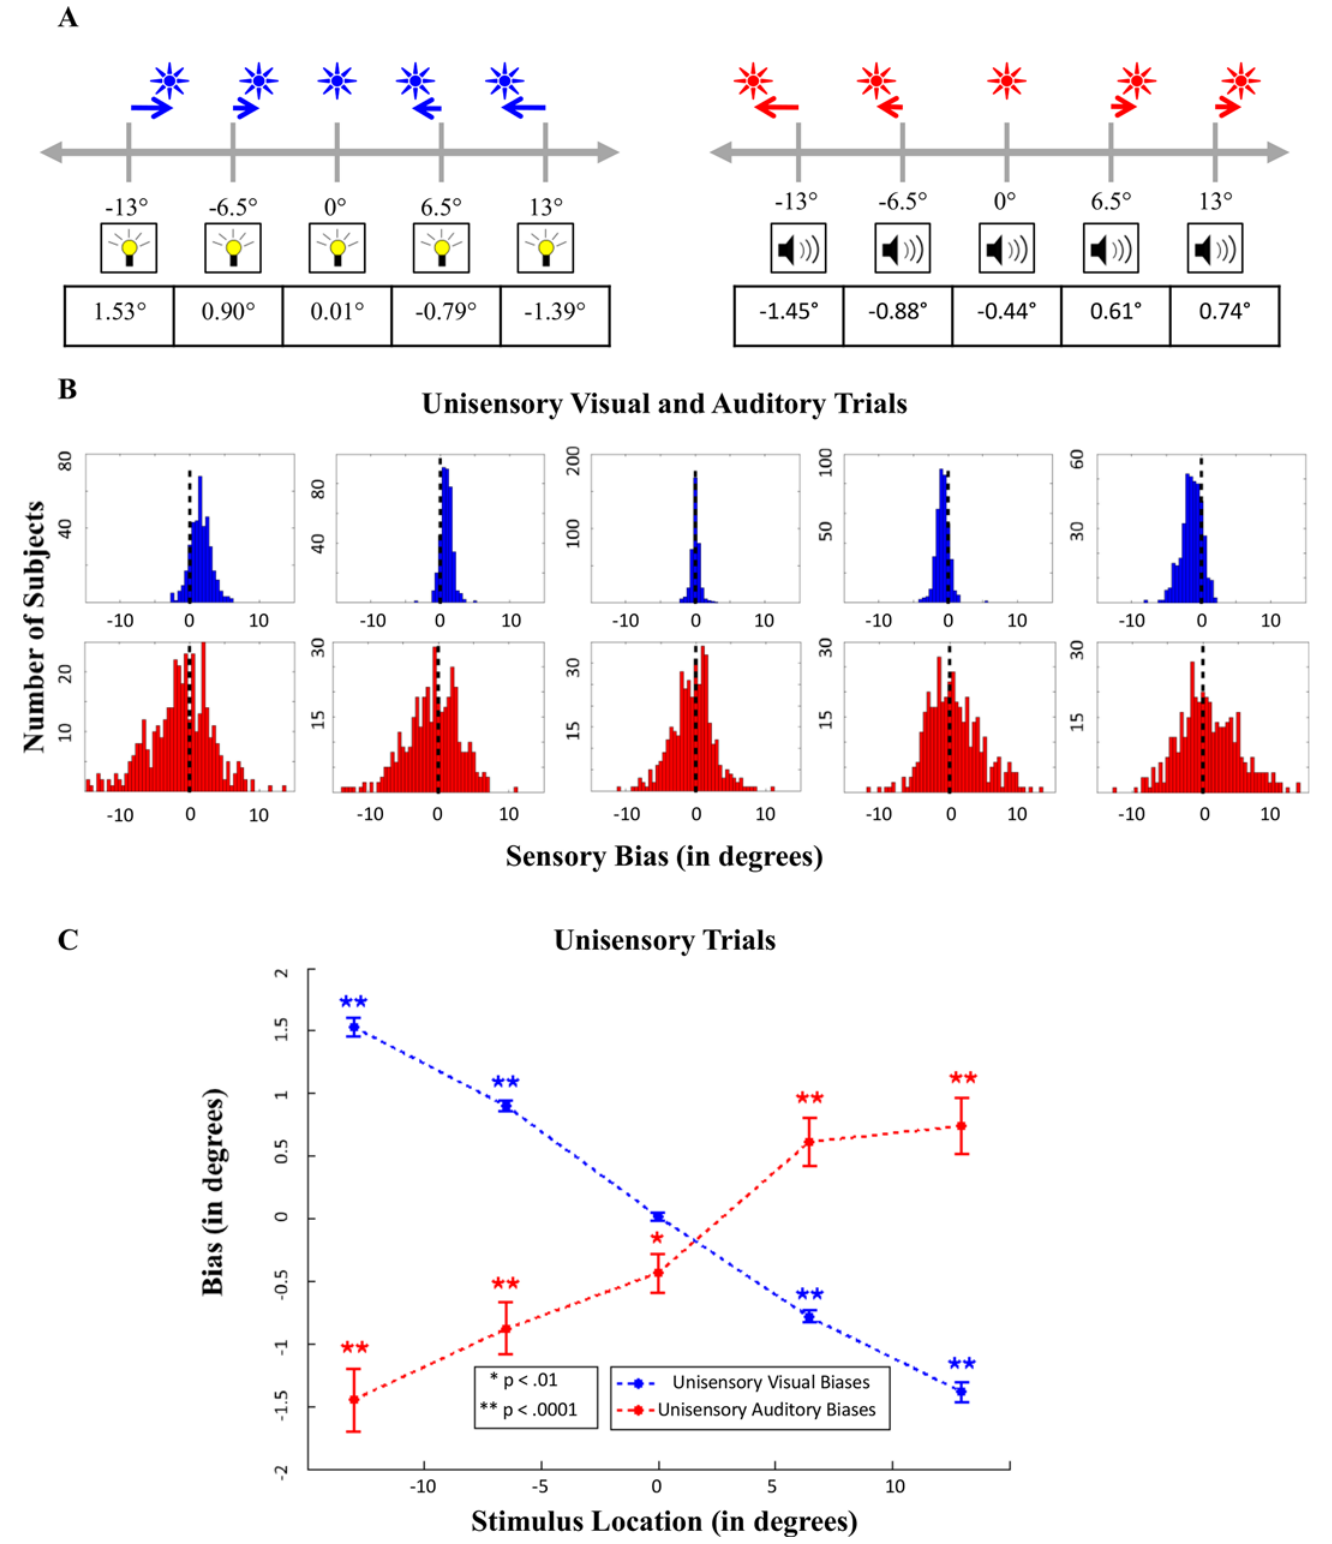
Fig 3. Biases present in localizations on unisensory trials. A) Average biases across subjects. B) The distribution of subjects ’ individual biases (based on each subjects ’ mean across 15 trials) for each of the five locations, from -13 degrees in the leftmost column, to +13 degrees in the rightmost column.